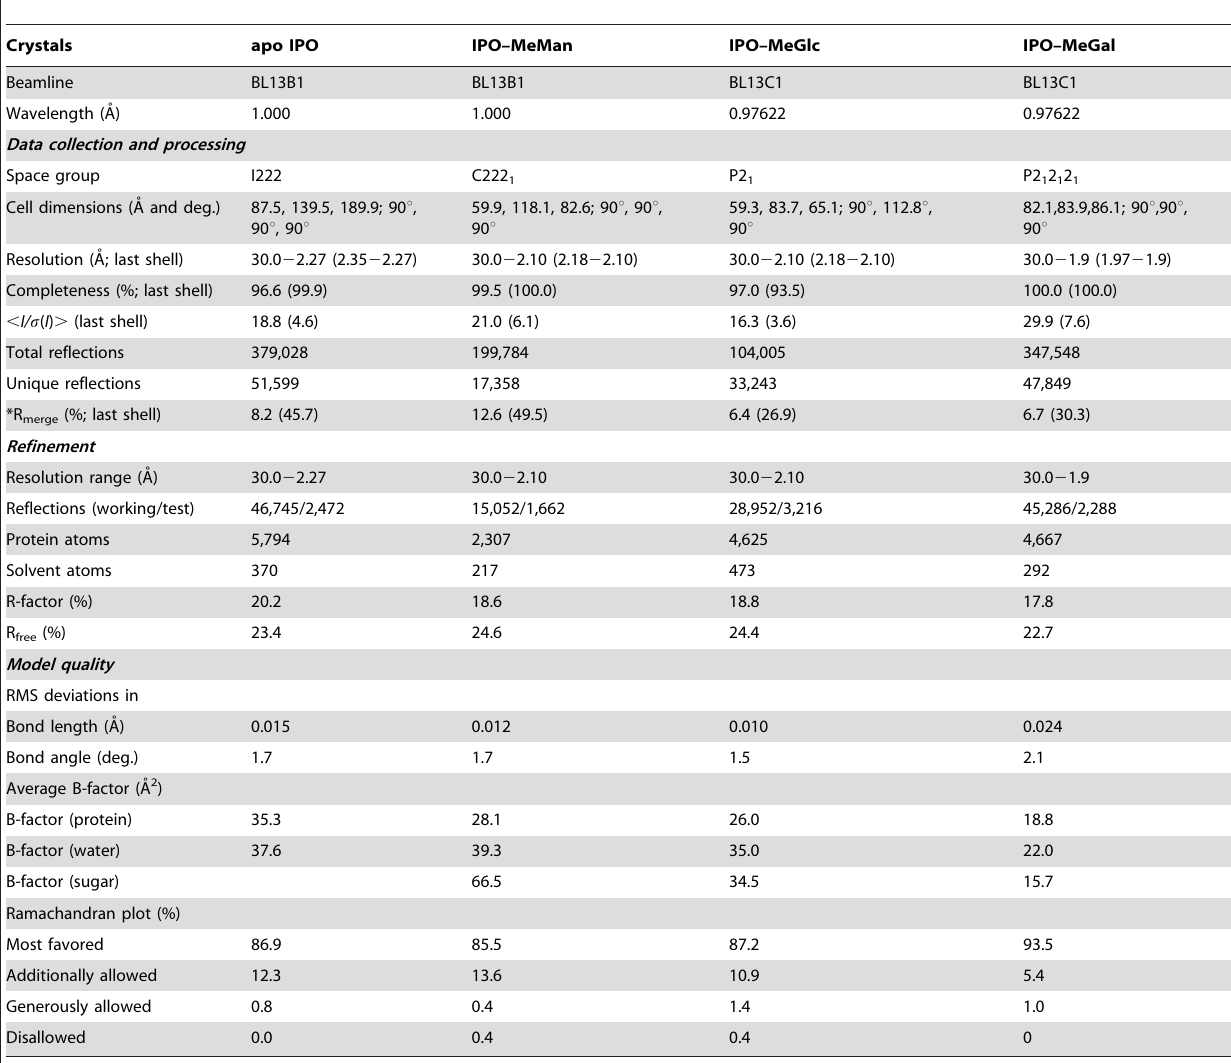
Table 3. Crystallography statistics for apo ipomoelin (IPO) and IPO in complex with carbohydrates methyl a -D-mannopyranoside (Me-Man), methyl a -D-glucopyranoside (Me-Glc) and methyl a -D-galactopyranoside (Me-Gal).